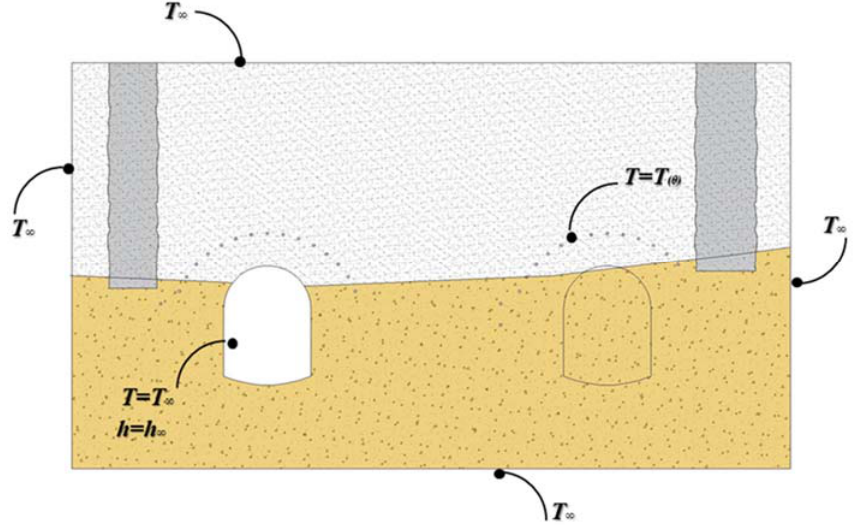
Figure 8. Computational domain and boundary conditions after the excavation of the odd tunnel.